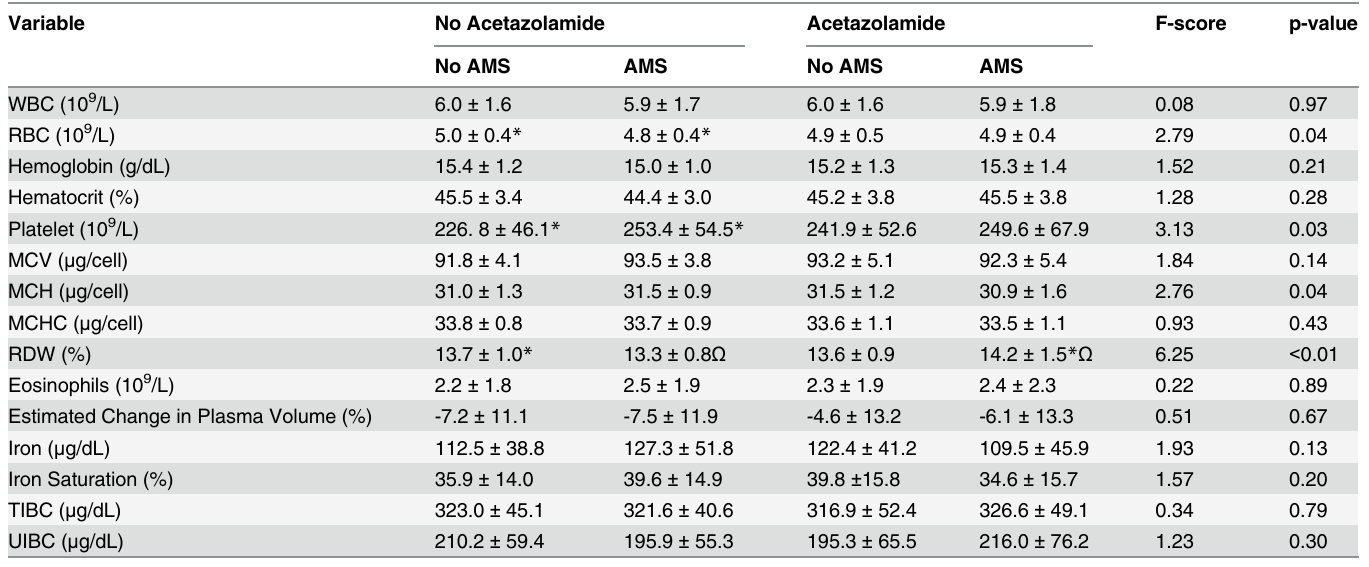
Table 3. Hematological